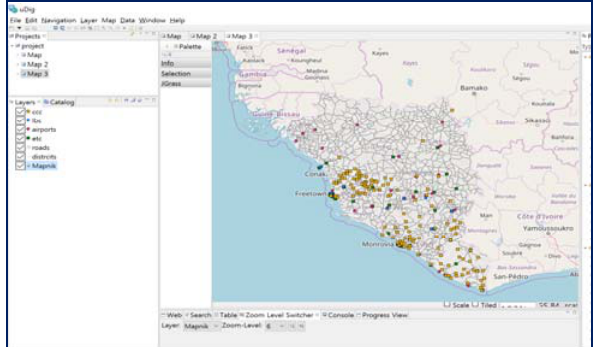
Figure 7. Ebola Dataset displayed on uDig SW